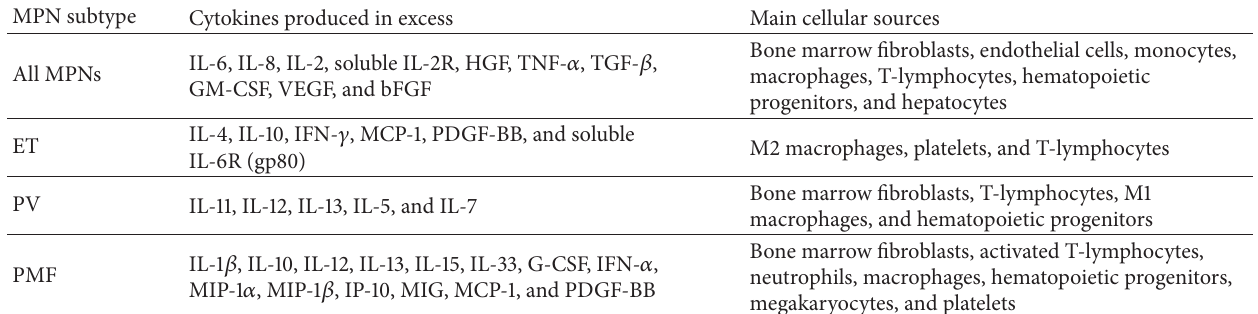
Table 1: Qualitative differences in inflammatory cytokine expression in ET, PV, and